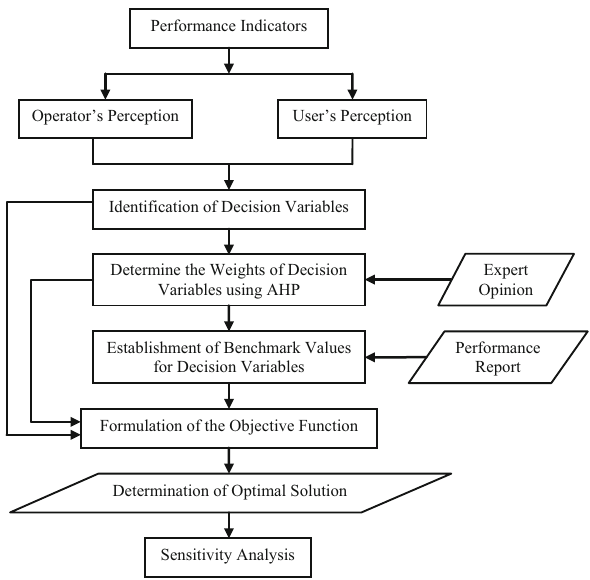
Fig. 1 Performance optimization methodology integrating users’